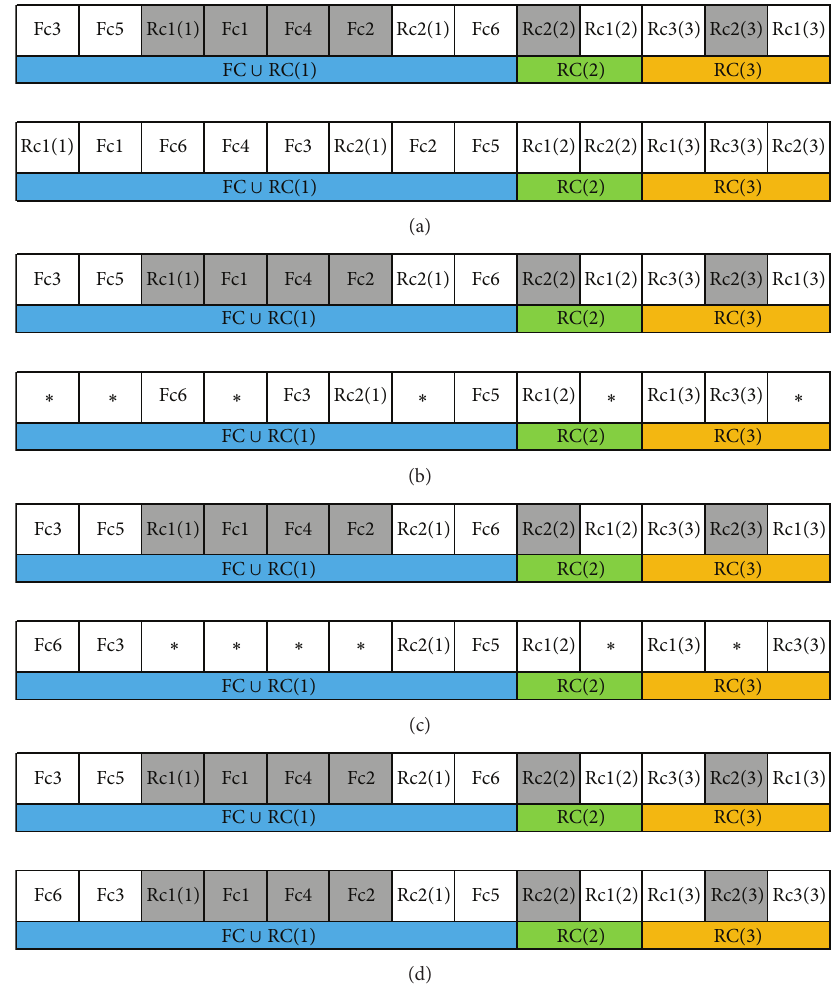
Figure 8: Nonwrapping ordered crossover